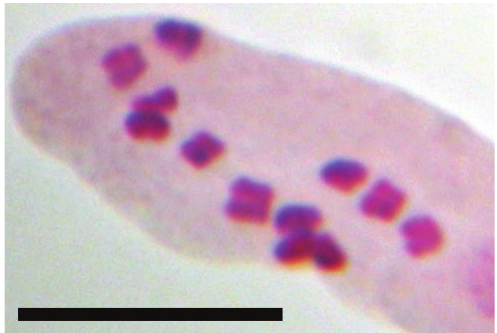
Figure 3. Linaria purpurea (L.) Mill., 2 n = 12. Scale bar: 10 μm.